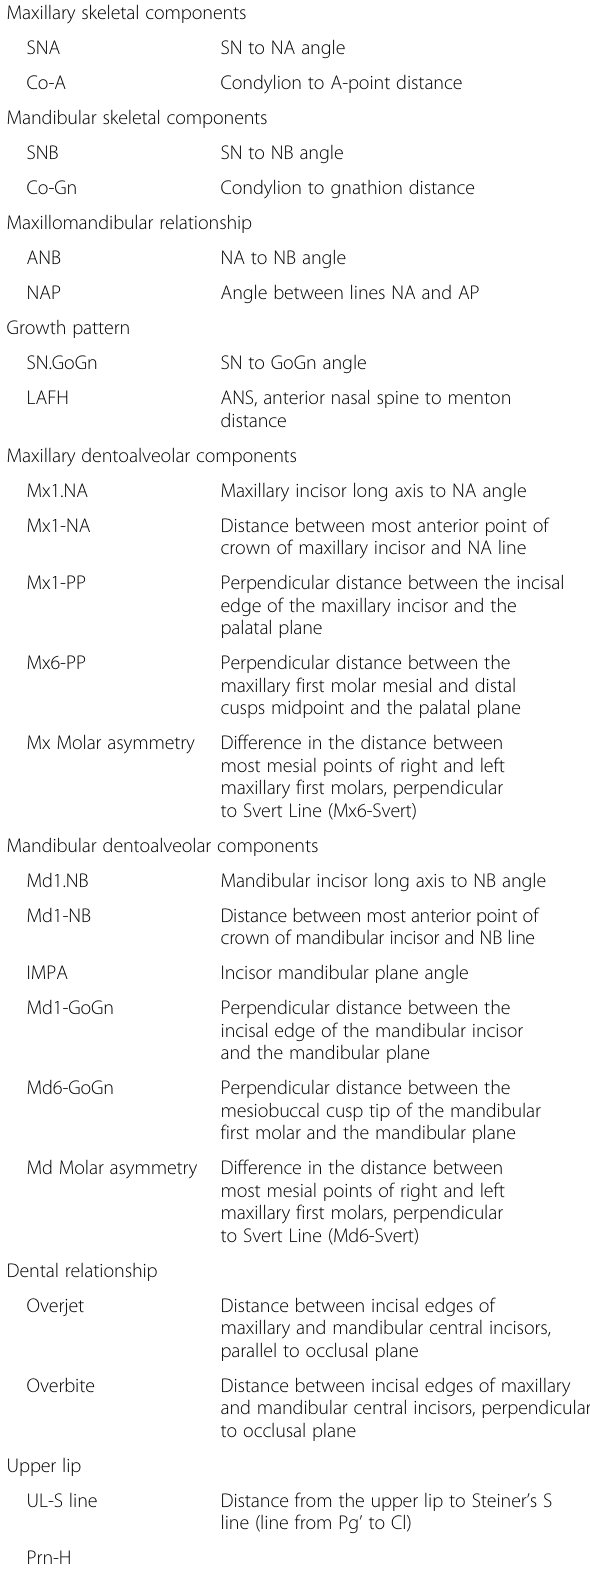
Table 1 Skeletal, dental and soft tissue cephalometric variables